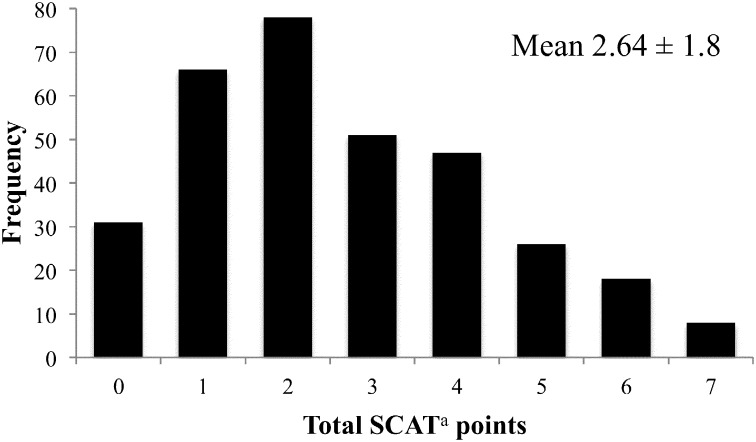
Distribution of SCATa scores obtained from 315 corner store audits in 2014 in four New Jersey citiesaShort form Corner store Audit Tool.